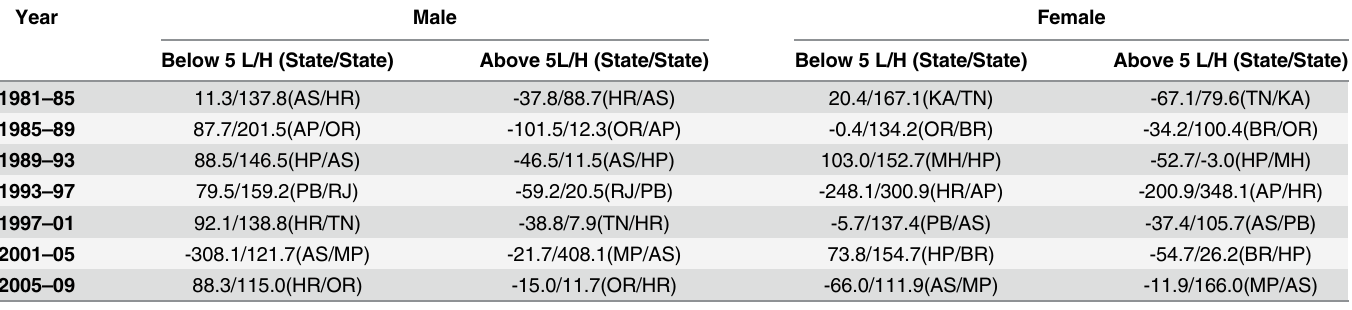
Table 5. Lowest (L) and highest (H) value of the share mortality below age five and above age five in convergence towards crossover between life expectancies at ages zero and five, 1981 –